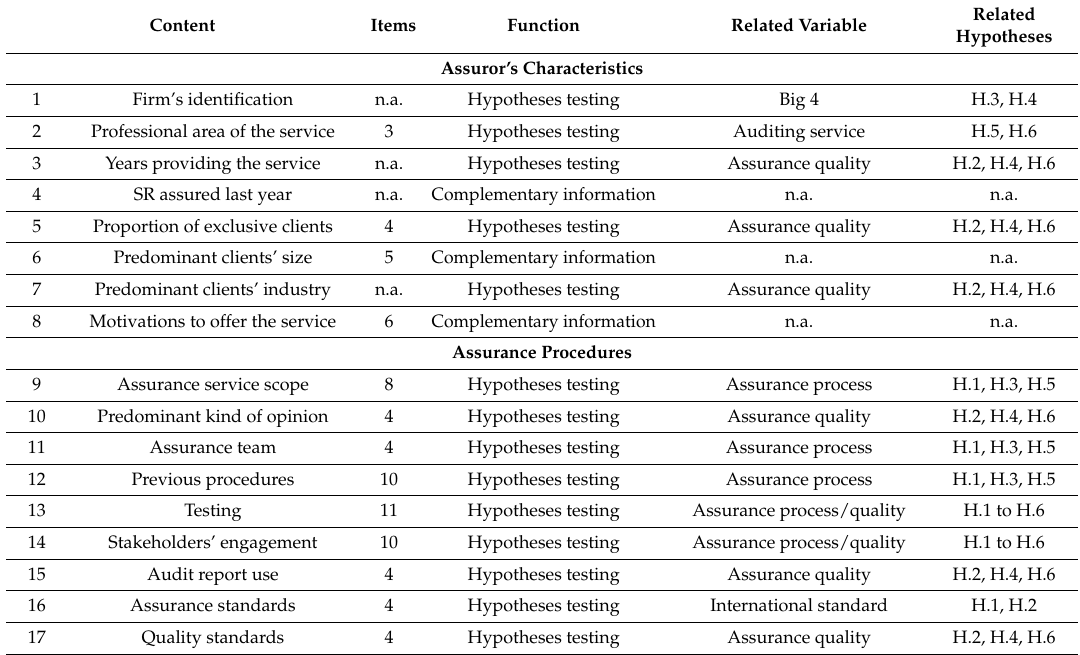
Table 2. Questionnaire